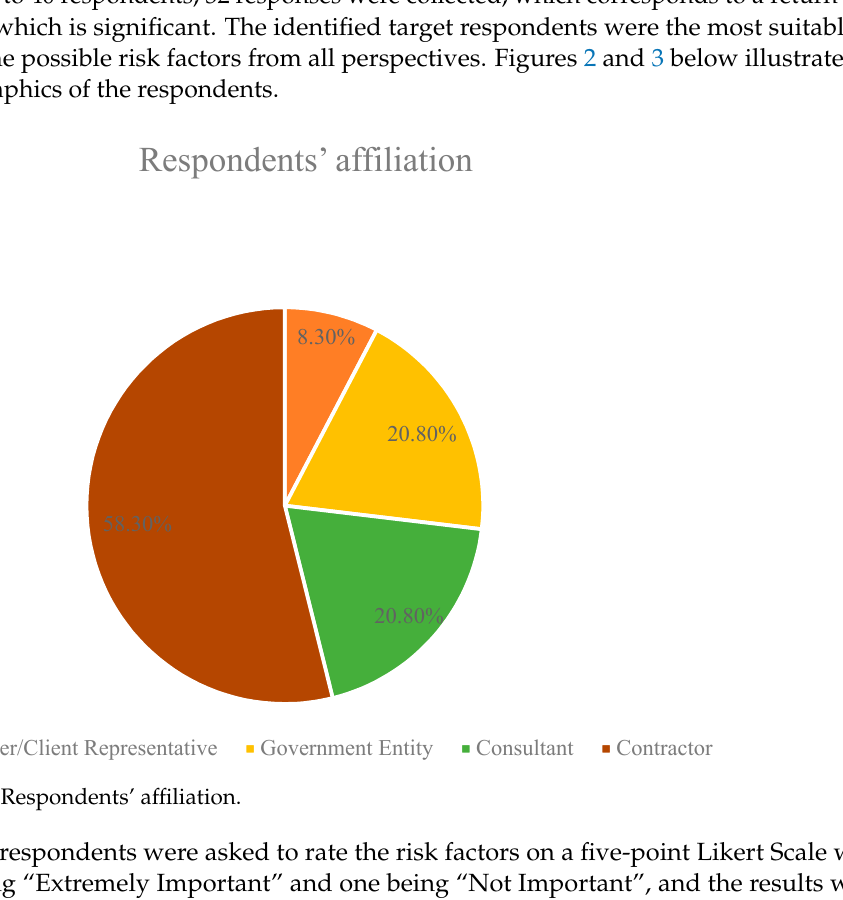
Figure 3. Respondents’ experience. All respondents were asked to rate the risk factors on a five-point Likert Scale with five being “Extremely Important” and one being “Not Important”, and the results were analyzed to calculate the RII, as shown in Table 8 below. The results show that the risk